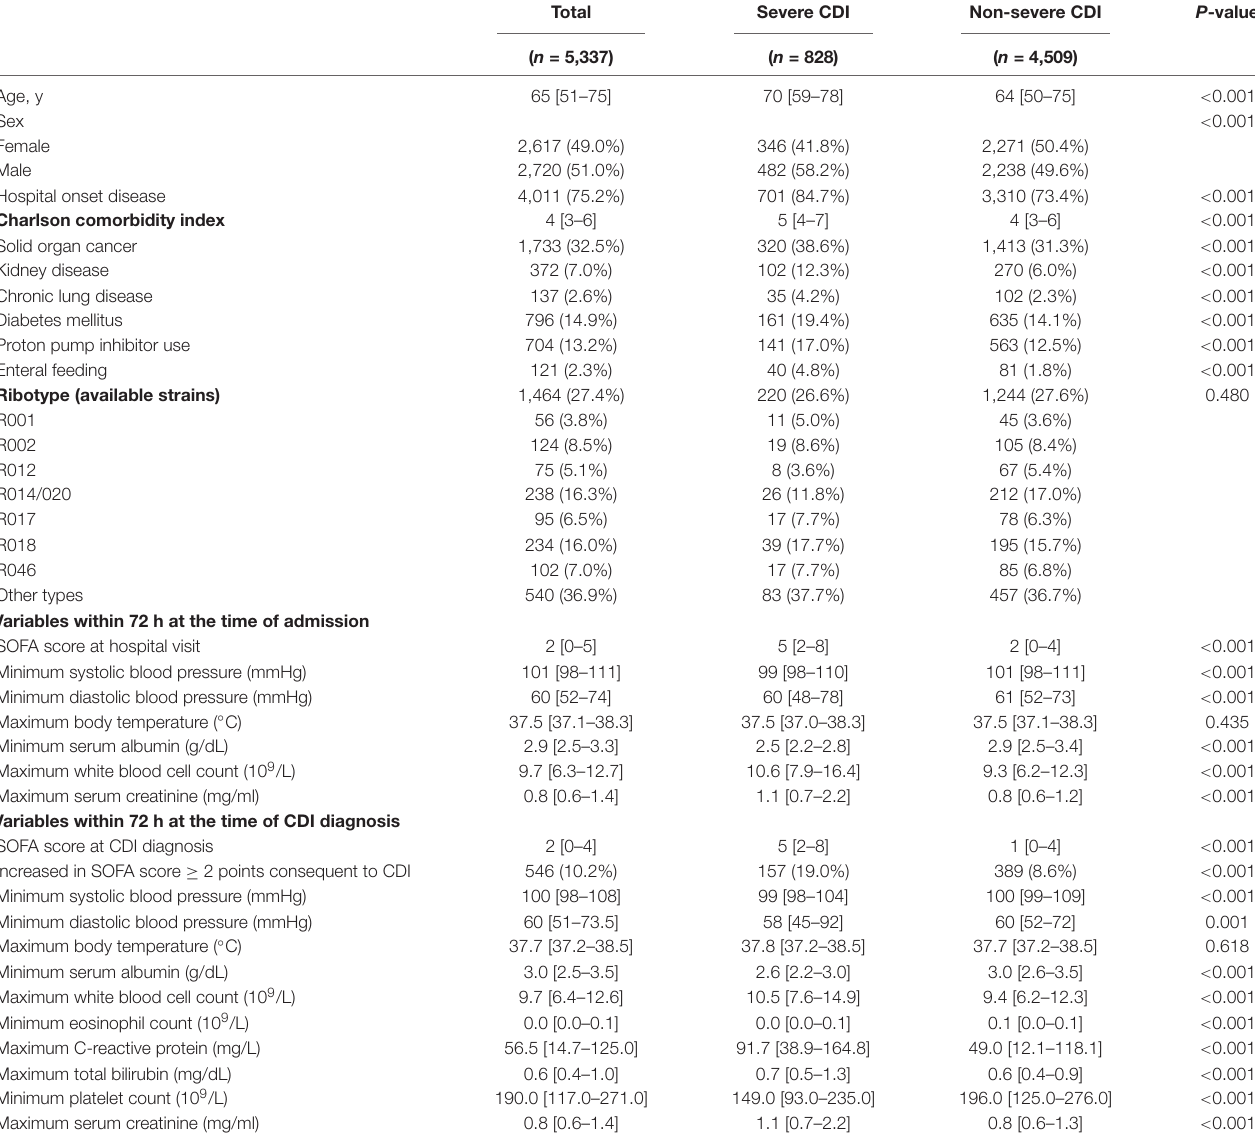
TABLE 1 | Baseline characteristics of patients with CDI, before propensity-score